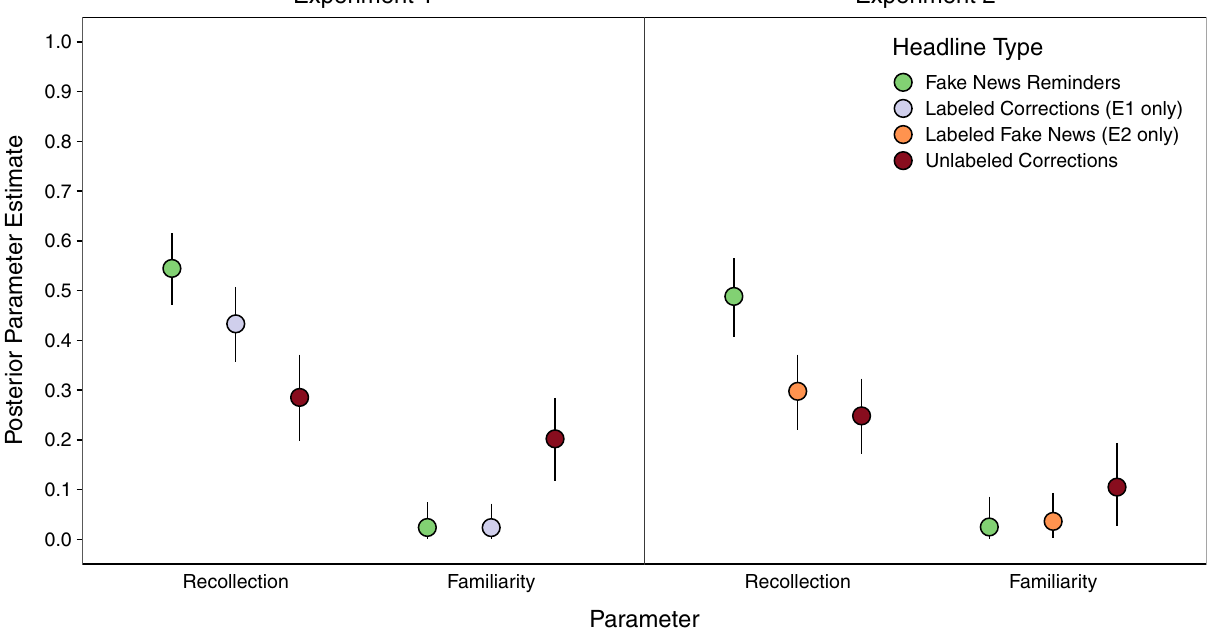
Figure 4. Latent parameter estimates for recollection and familiarity for each correction headline type condition. Points are posterior parameters estimated with MPT models, and error bars are 95% credibility